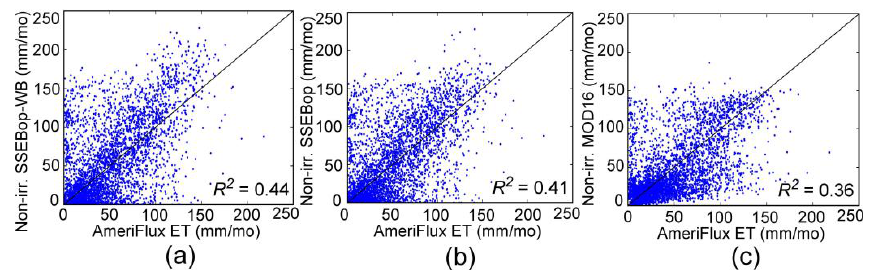
Figure 6. Comparisons of AmeriFlux data with the ET predictions only in tower locations where the MIrAD-US product (Figure 2) did not indicate active irrigation, for ( a ) scaled SSEBop; ( b ) SSEBop; and ( c ) MOD16.